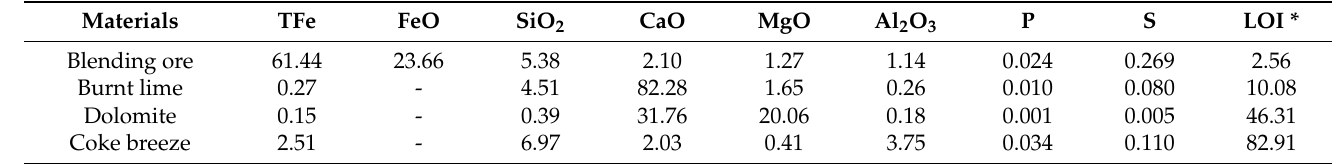
Table 1. Chemical compositions of raw